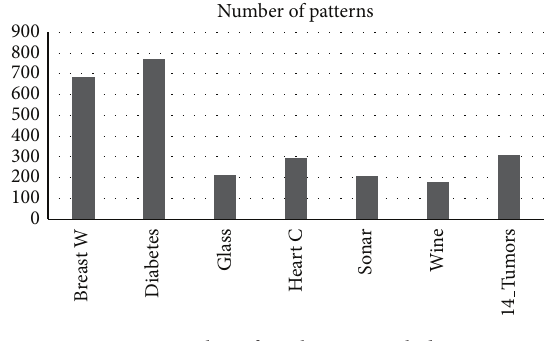
Figure 7: A sample array in the first stage.